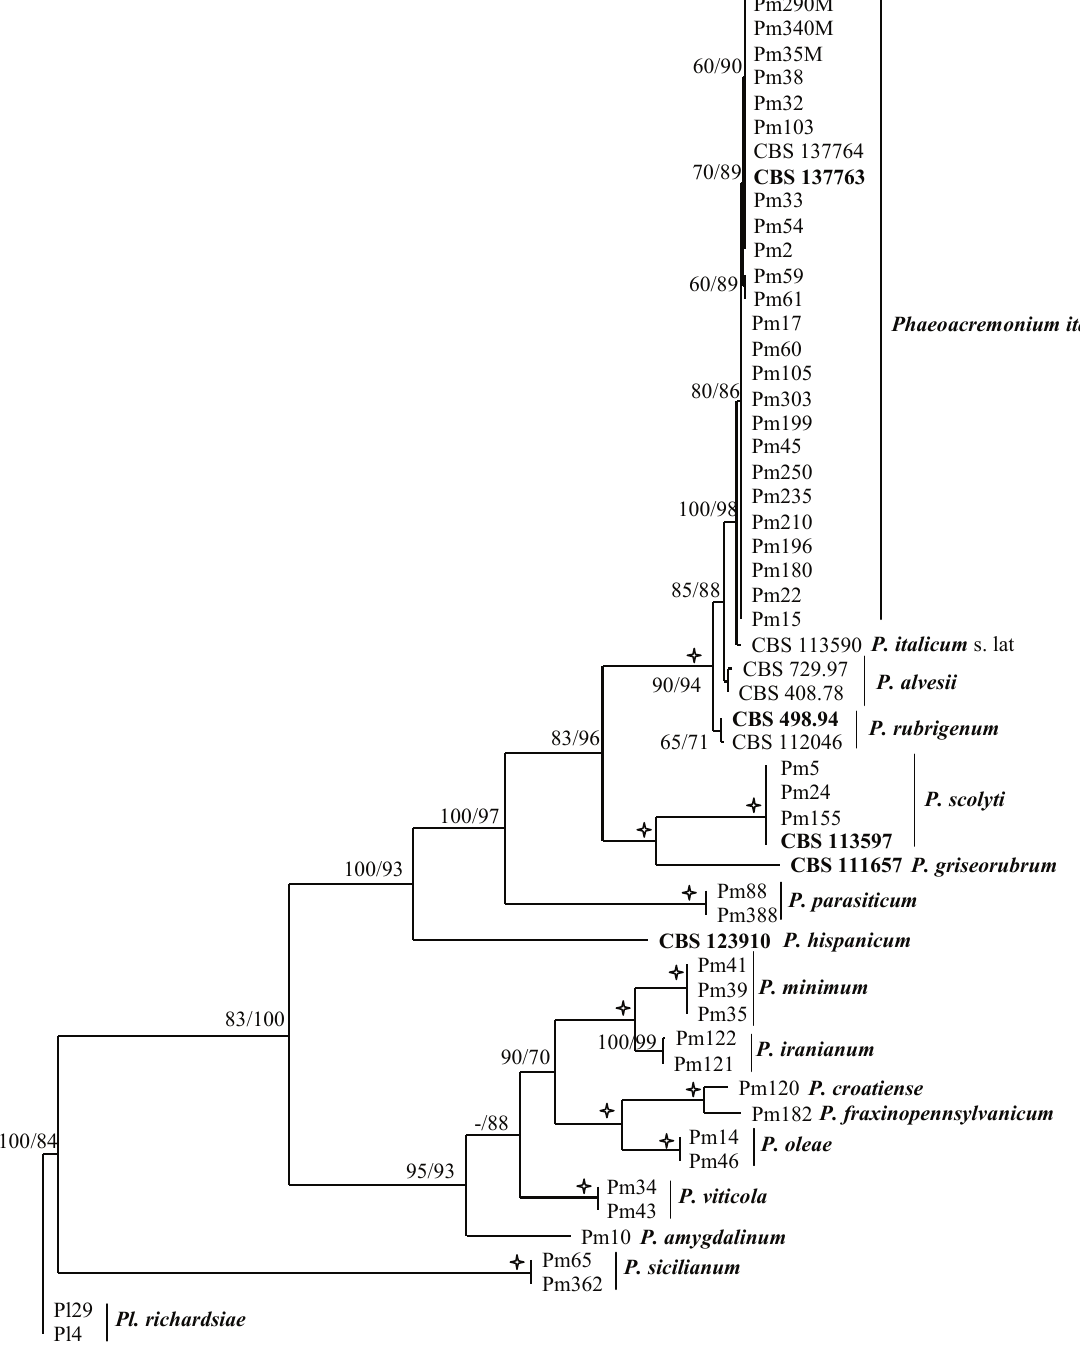
Figure 6. The most parsimonious tree obtained from multiple alignment of the β-tubulin and actin genes, with bootstrap values (1000 rep- licates) from maximum parsimony/maximum likelihood shown at the internodes. Bootstrap values of 100% are indicated with star symbols, and ex-type sequences are highlighted in bold. Pleurostoma richardsiae was included as an